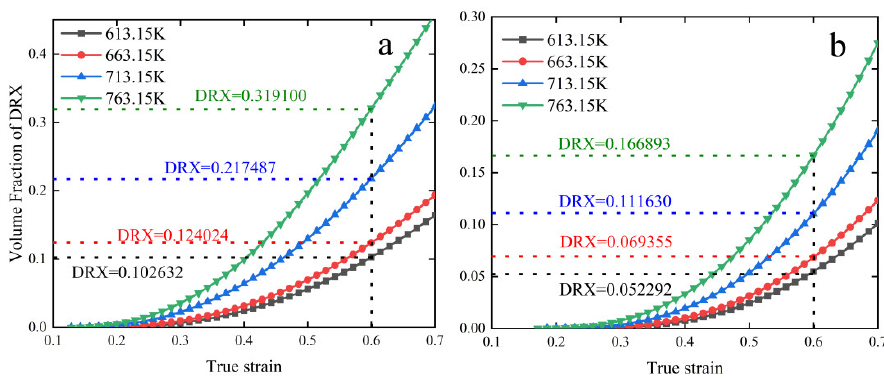
Figure 11. Crystallization volume fraction prediction curves: ( a ) 0.01 S − 1 , ( b ) 10 S − 1 . When the strain rate is constant, the increase in DRX volume fraction is